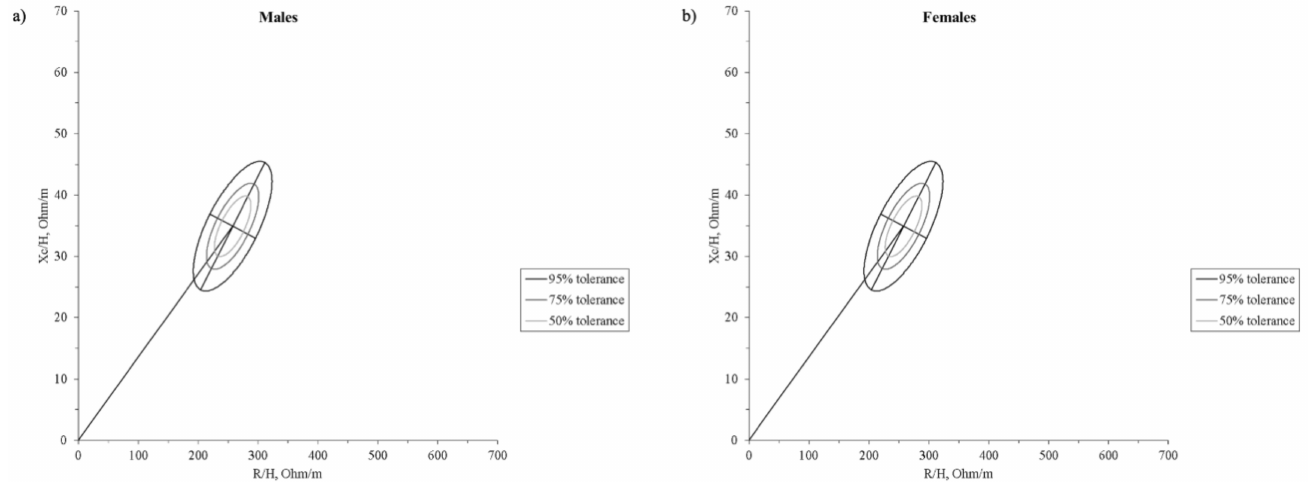
Figure 2. Tolerance ellipses at 50%, 75%, and 95% generated for ( a ) the male (U17 and U19) and ( b ) female (U19) youth team handball squads. R/H, height-adjusted resistance; Xc/H, height-adjusted reactance.